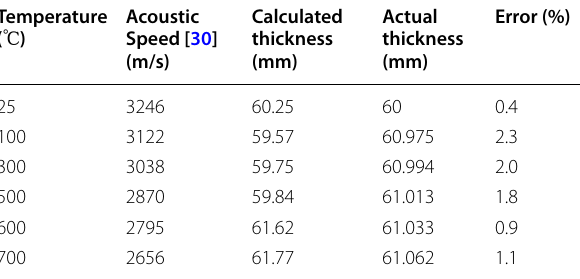
Table 3 Thickness measurement of Cr25Mo3Ti at different